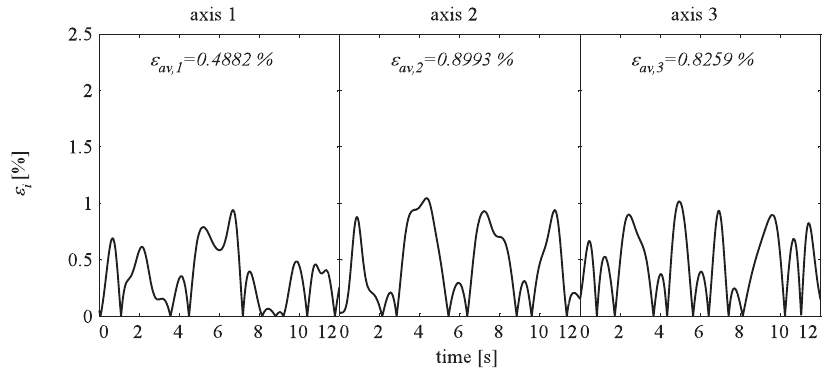
Figure 8. Di ff erence between multibody model and mathematical model.